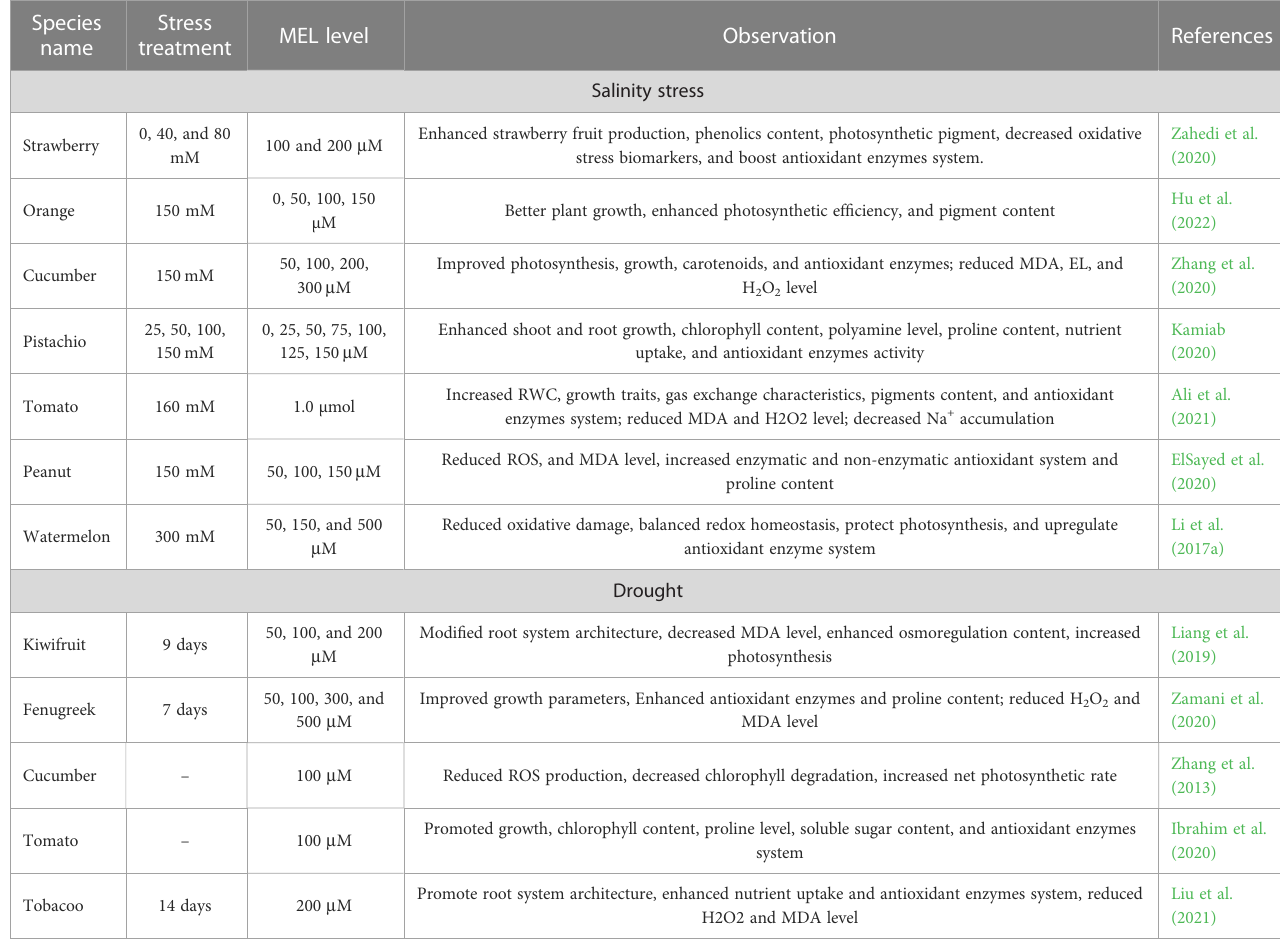
TABLE 3 Melatonin enhanced salinity and drought stress tolerance in horticultural